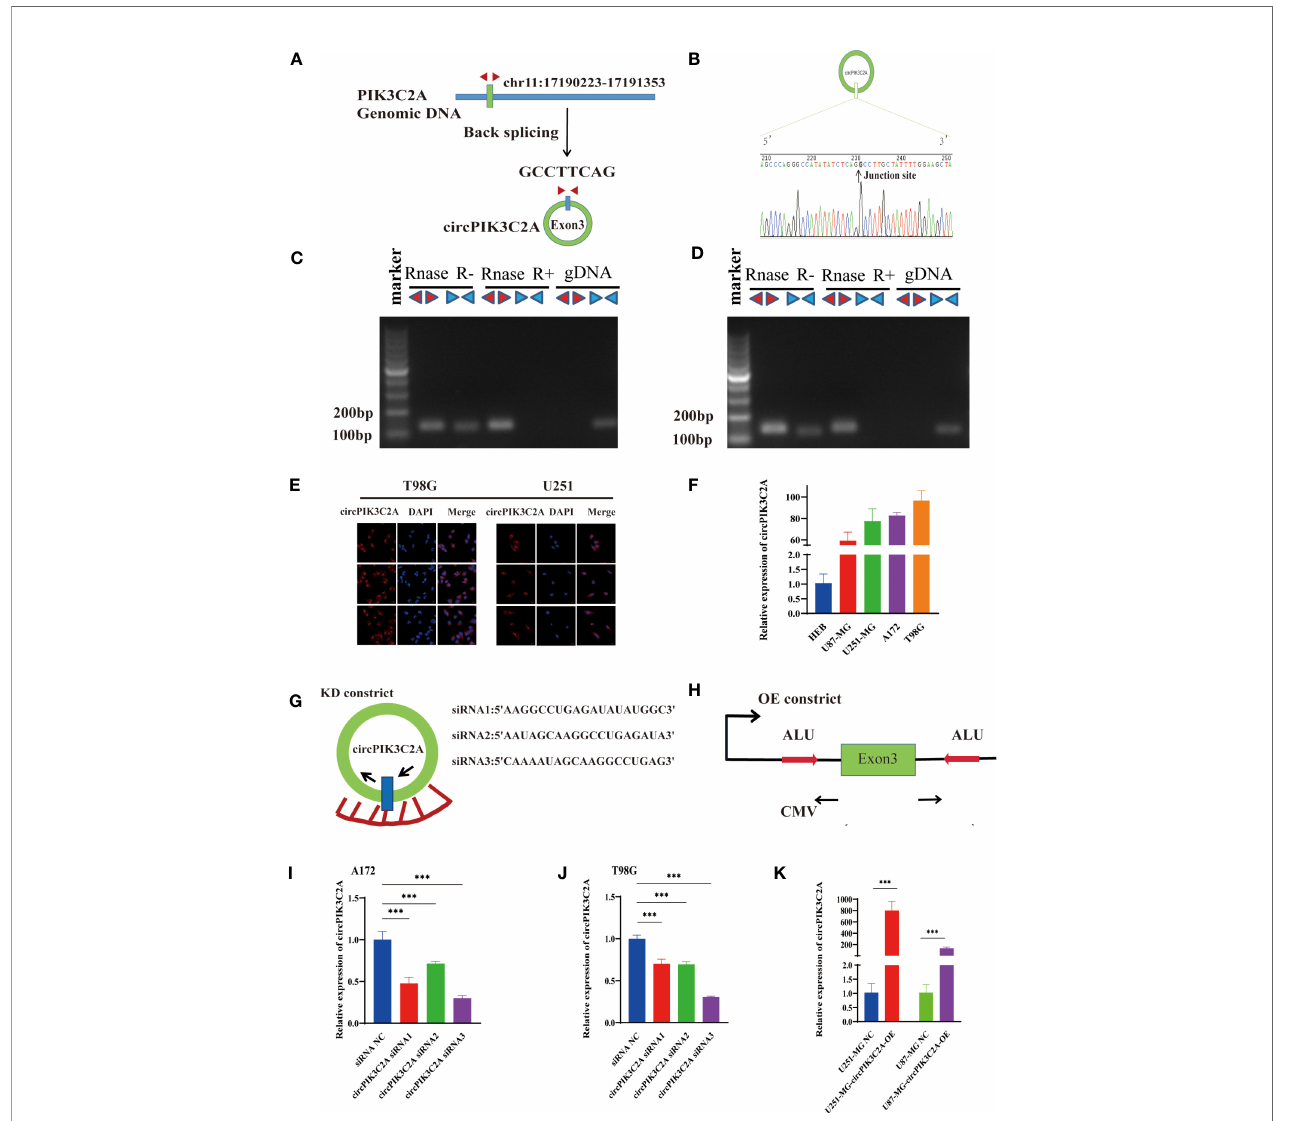
FIGURE 1 | Identi fi cation and expression of circPIK3C2A in GBM cells. (A) The structure and part of the sequence of the junction of circPIK3C2A are provided, and divergent (red) primers were designed to amplify the back-splicing products. (B) Sanger sequencing after PCR using the indicated divergent fl anking primers con fi rmed the “ head-to-tail ” splicing of circPIK3C2A. (C, D) The expression levels of the backspliced and canonical forms of PIK3C2A in cDNA and gDNA isolated from T98G and U251-MG cells. Red arrows represent divergent primers; blue arrows represent convergent primers. (E) CircPIK3C2A was detected by FISH in T98G and U251-MG. Nuclei were stained with 4 ′ ,6 ′ -diamidino-2-phenylindole. Scale bar = 20 m m. (F) Quantitative RT-PCR analysis of circPIK3C2A in GBM cells and HEBs. (G) A sketch of the short hairpin circPIK3C2A vector structure. (H) A sketch of the circPIK3C2A overexpression vector structure. ALU: Complementary ALU pairs were identi fi ed as at least one plus strand and one minus strand ALU element on opposite sides of the back-splice, which was required for the formation of circRNA; CMV: a common promoter in vectors. (I – K) Quantitative RT-PCR analysis of circPIK3C2A expression in GBM cells. Data are presented as the mean ± SEM of 3 independent experiments. Signi fi cant results are presented as